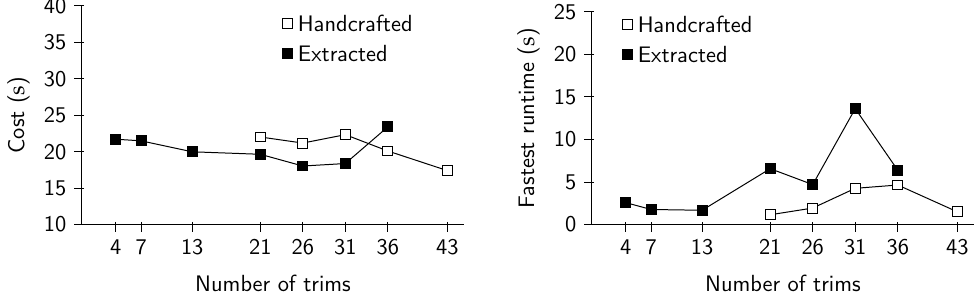
Figure 10. Results for the same problem with fixed trim’s duration of